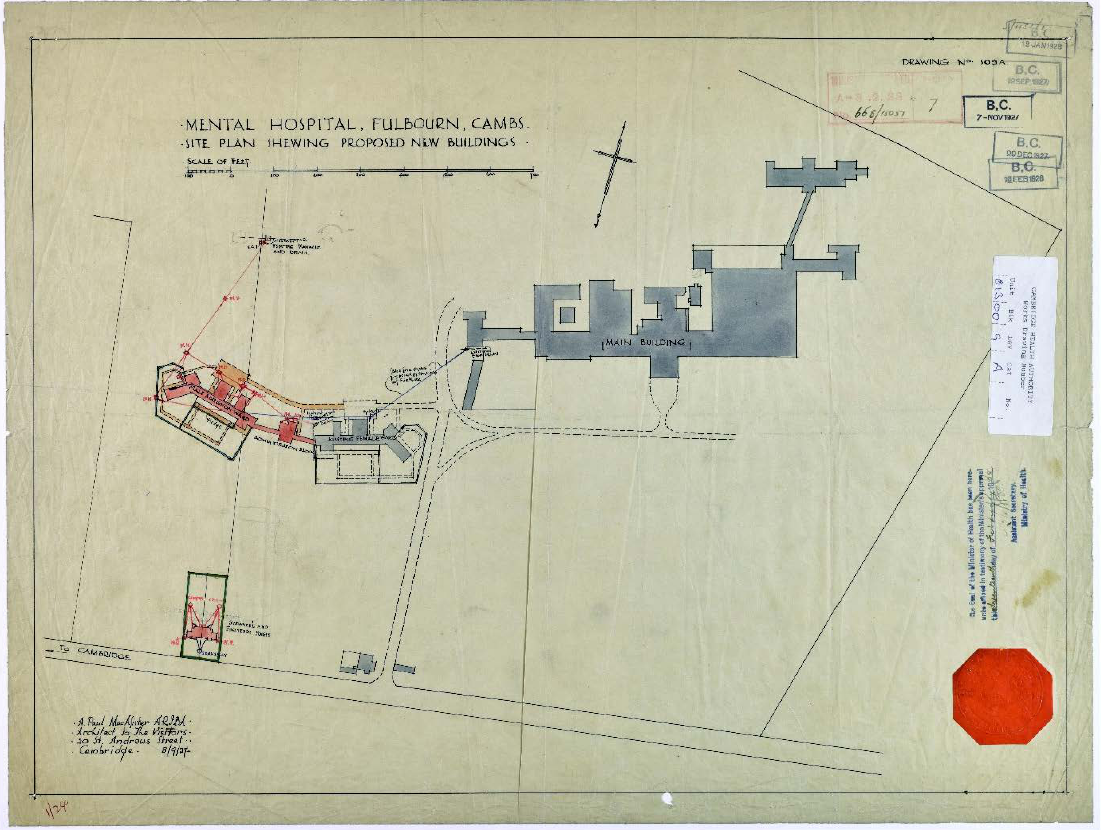
Figure 7. Inter-war Admission Wards, Fulbourn Hospital, Cambridgeshire, site plan, 1927 (Source: ‘Plans of new admission wards’, ‘Site Plan Shewing [ sic ] Proposed New Buildings’ [incl. Administration Block and new Male Admission Ward, as added to Existing Female Ward], 1927, KHF/5/1/11, Cambridgeshire Archive Services, Ely, Cambridgeshire,